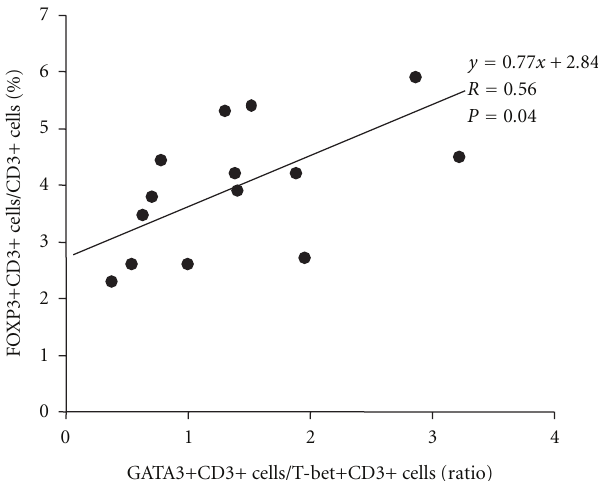
Figure 5: The correlation between the percentage of FOXP3- positive T lymphocytes and Th1/Th2 ratio in allergic nasal mucosa ( n = 14). Linear regression analysis was used to determine the relationship between the percentage of FOXP3-positive cell in CD3- positive cells and the ratio of GATA-3+CD3+ cells/T-bet+ CD3 cells in allergic nasal